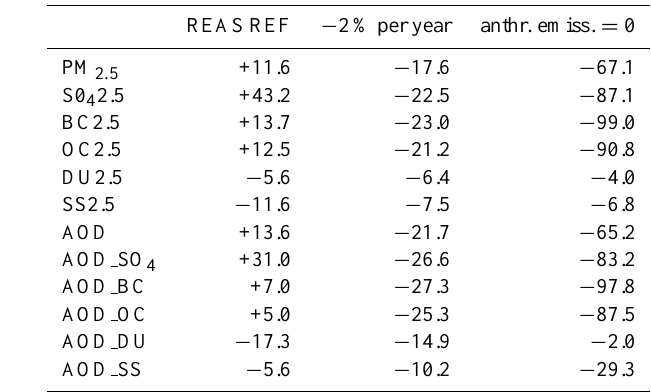
Table 2. Percentage changes of mass concentration and AOD of dif- ferent aerosol species in India. Change from simulation of present- day Asia in the different